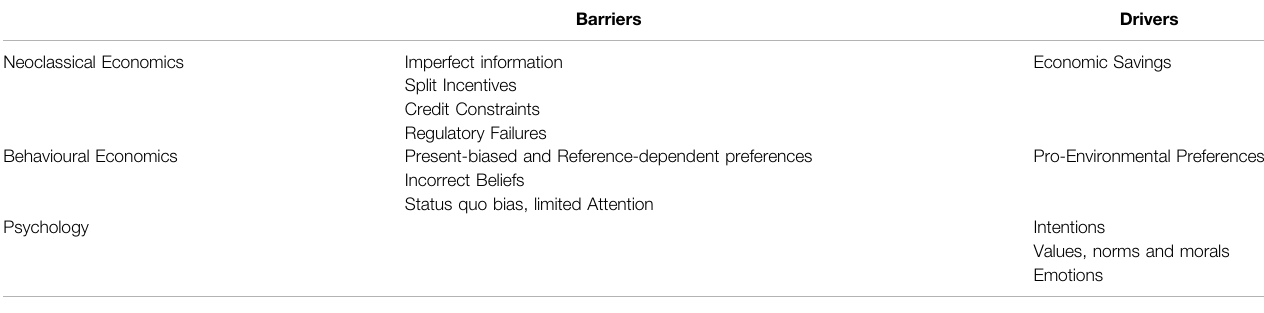
TABLE 1 | “ Summary of barriers and drivers ” .